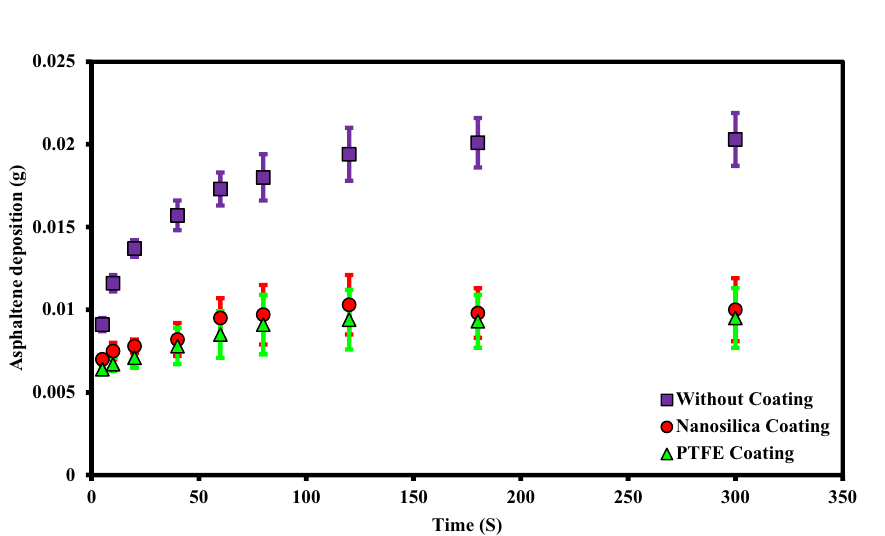
Table 2. The design of experiments to investigate the effect of coating type on asphaltene deposition in static sate.